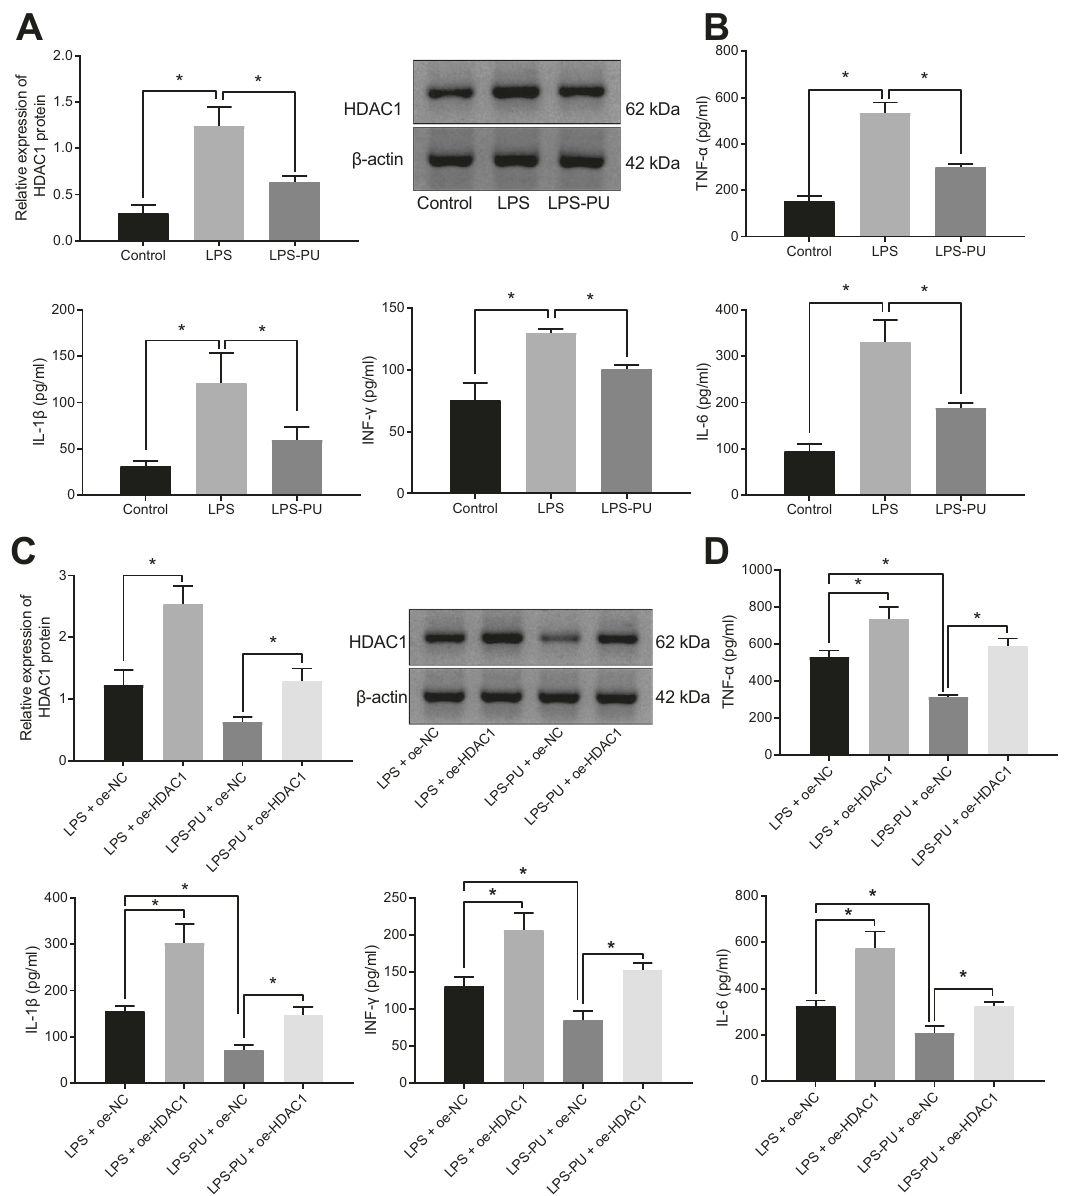
Fig. 2 PU exerts inhibitory effect on LPS-induced in fl ammation by HDAC1. A HDAC1 protein expression in RAW 264.7 cells. B The level of in fl ammatory factors (TNF- α , IL-1 β , INF- γ and IL-6) in RAW 264.7 cell supernatant assayed by ELISA. C The expression of HDAC1 in RAW 264.7 cells after transduction assayed by western blot analysis. D The level of lung in fl ammatory factors (TNF- α , IL-1 β , INF- γ , and IL-6) in the transduced RAW 264.7 cell supernatant. * p < 0.05. promotes ALI [22]. Thus, the expression of NLRP3 in fl ammasome- related indicators in animal and cell models was fi rst detected by Western blot analysis and the outcomes (Fig. 4A, B) indicated that ALI mouse lung tissues and LPS-induced cells showed elevated expression levels of NLRP3, pro-IL-1 β , and Caspase-1 p20 protein, but Caspase-1 levels did not signi fi - cantly change. To discern that LPS-induced NLRP3 in fl ammasome activation was related to PP2A, RAW 264.7 cells were transfected with overexpressed PP2A. Western blot analysis was used to detect PP2A and NLRP3 in fl ammasome-related indicators and results revealed that (Fig. 4C) the expression of PP2A in LPS-treated cells upon PP2A treatment was increased, and the expression of NLRP3, pro-IL-1 β , and Caspase-1 p20 protein was reduced, while Caspase-